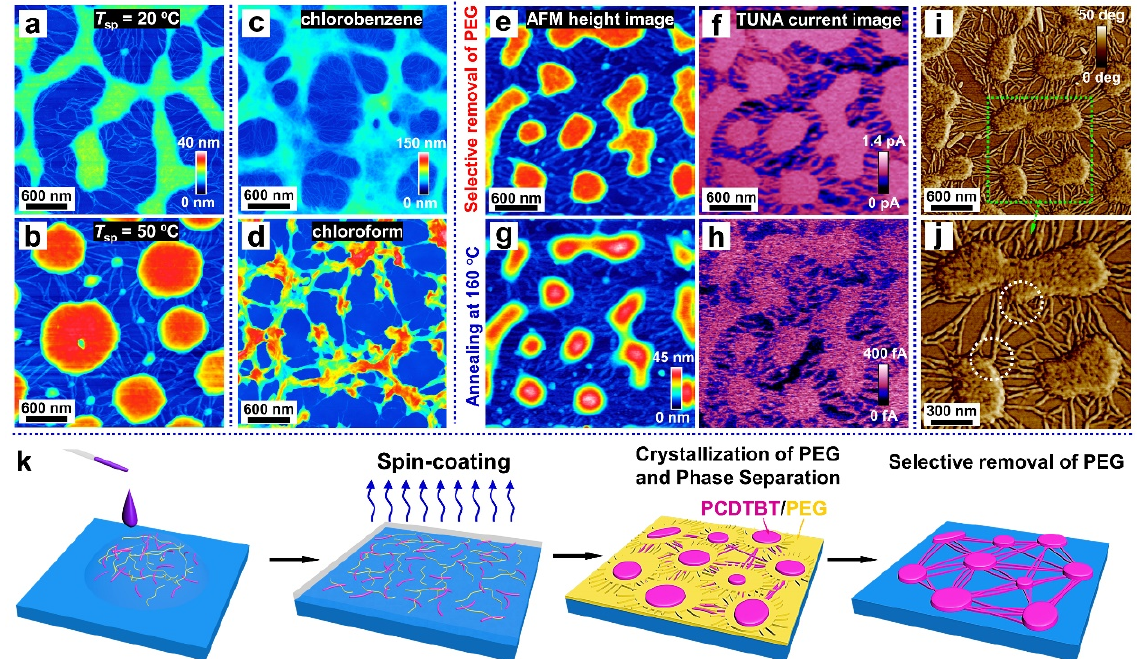
Figure 4. Mechanism of the formation of the PCDTBT network. AFM height images of the washed films correspond to blend films produced at different spin-coating temperatures ( T sp ): ( a ) 20 ◦ C and ( b ) 50 ◦ C. AFM height images of the washed films correspond to blends spin-casted from solutions with different solvents: ( c ) chlorobenzene and ( d ) chloroform. ( e , g ) AFM height images and ( f , h ) corresponding TUNA current maps of PCDTBT aggregates and nanofibers. ( i , j ) AFM phase images of PCDTBT aggregates and nanofibers. ( k ) Schematic representation of the formation of PCDTBT aggregates and nanofibers at various